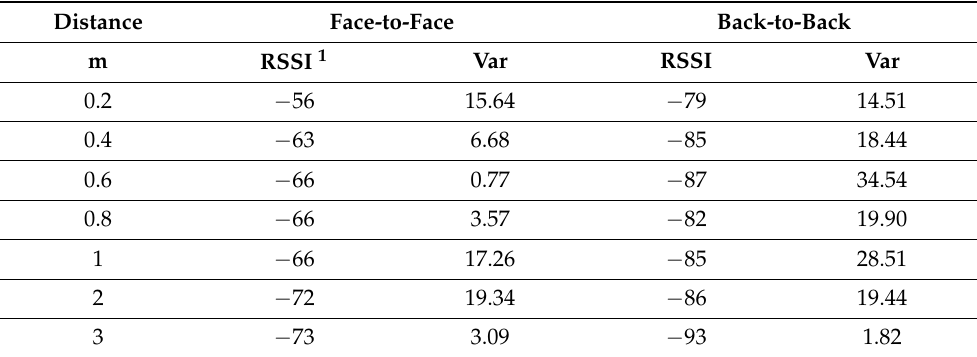
Table 3. Antenna orientation influence on the RSSI.